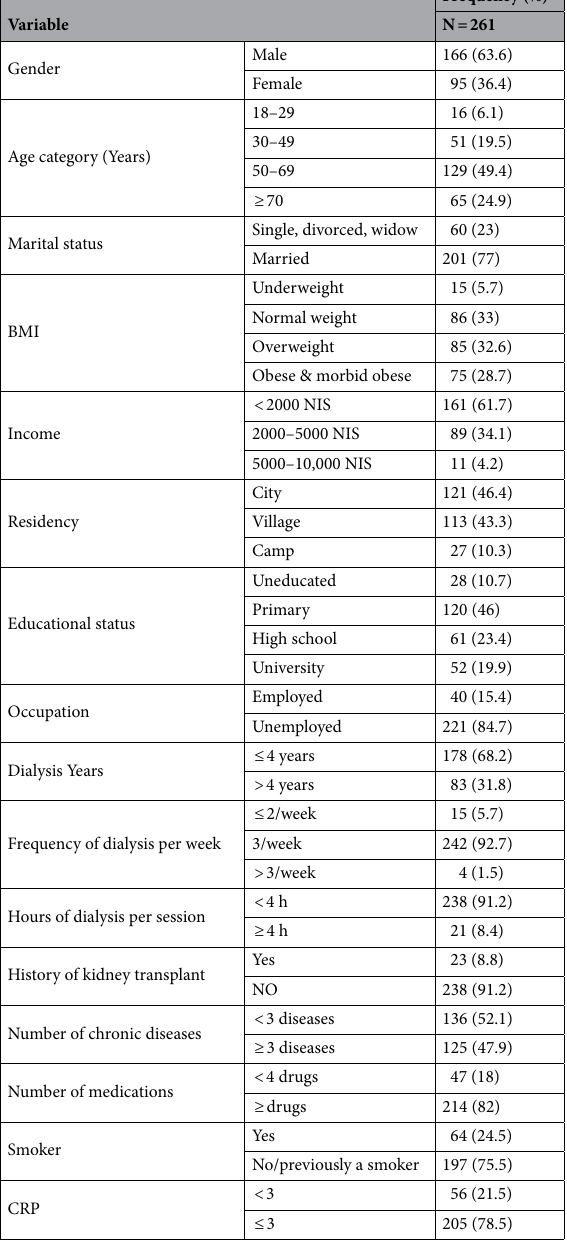
Table 1. Sociodemographic and clinical characteristics of the study sample. BMI, body mass index; NIS, new Israeli shekel (1NIS = 0.30 US